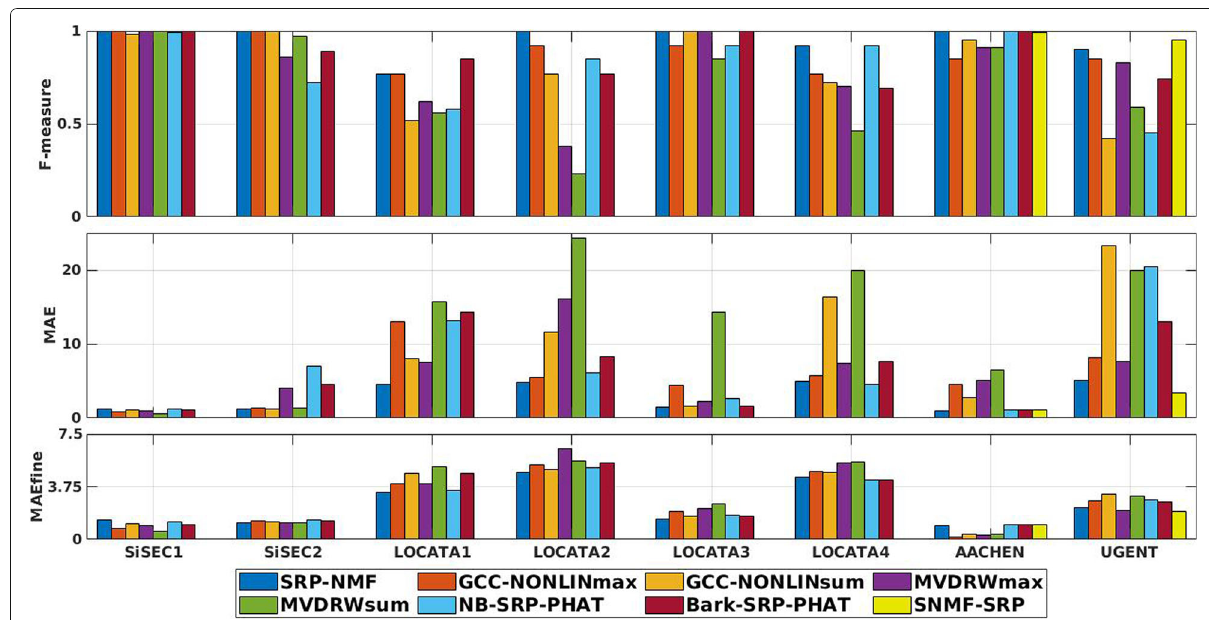
Fig. 9 F-measure, MAE and MAEfine of SRP-NMF and comparison approaches on various datasets. Mean azimuth error between ground truth azimuths and the detected azimuths (MAE) is the gross location accuracy metric. F-measure is the detection metric. Mean azimuth error between ground truth azimuths and the correctly detected azimuths (MAEfine) is the fine location accuracy metric